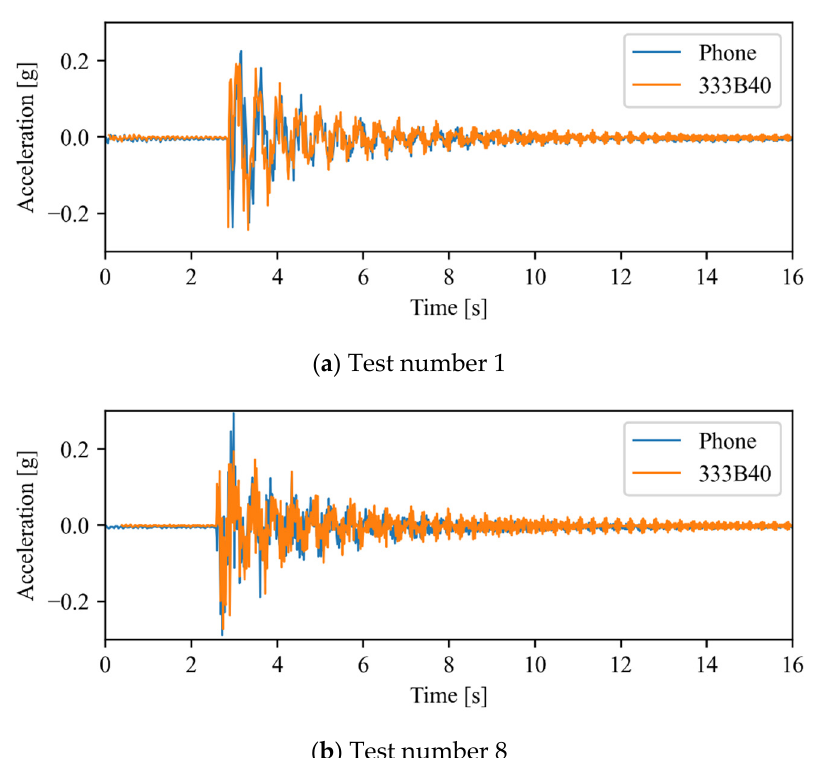
Figure 8. Time series comparison (393B12 vs. 333B40).